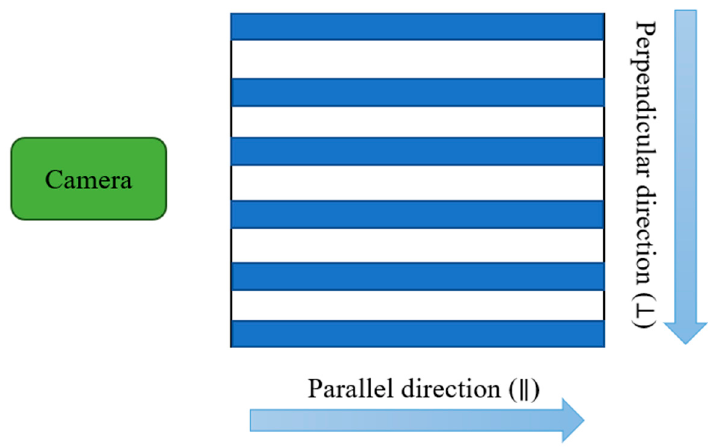
Figure 2. Definition of the parallel and perpendicular directions for the line pattern.